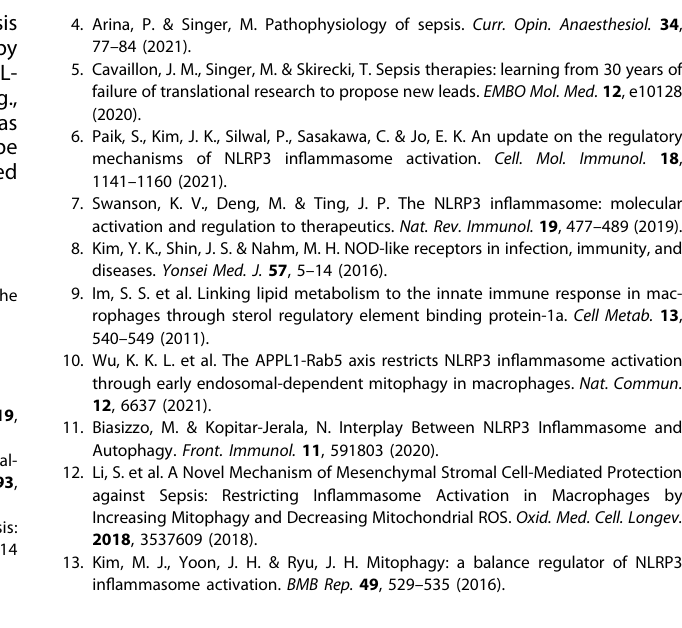
Fig. 8 Inhibition of aerobic glycolysis and lactate production by a p62 ligand in LPS-stimulated macrophages. a , b ECAR pro fi le ( a ) and representative ECAR parameters ( b ) in PMs pretreated with vehicle or ATB1021 (10 μ M) for 1h and stimulated with LPS for 6h. c Lactate levels in the supernatants of PMs pretreated with vehicle or ATB1021 (10 μ M) for 1h and stimulated with LPS for 18h ( n = 3). d PMs were pretreated with vehicle or ATB1021 (10 μ M) for 1h and then stimulated with LPS for 3, 6, or 18h; next, they were subjected to Western blotting analysis of HIF-1 α . Means±SDs are shown ( a – c ). Two-tailed Student ’ s t test ( b , c ) was used to determine statistical signi fi cance. ns; not signi fi cant, * p <0.05, *** p